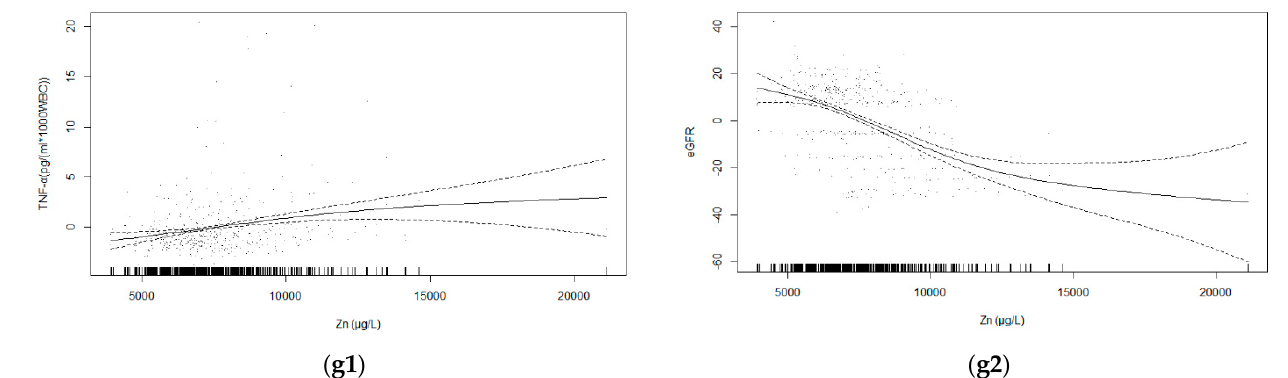
Figure 3. Relationships between ( a1 ) As ( p < 0.001), ( b1 ) Cd ( p = 0.062), ( c1 ) Pb ( p < 0.001), ( d1 ) Se ( p = 0.037), ( e1 ) Co ( p = 0.023), ( f1 ) Cu ( p = 0.165), ( g1 ) Zn ( p < 0.001) concentrations and the ratio of TNF- α and WBC based on generalized additive model after adjusting for age, gender, BMI, smoking status and alcohol consumption status. In addition are the relationships between ( a2 ) As ( p < 0.001), ( b2 ) Cd ( p = 0.003), ( c2 ) Pb ( p < 0.001), ( d2 ) Se ( p = 0.255), ( e2 ) Co ( p < 0.001), ( f2 ) Cu ( p < 0.001), ( g2 ) Zn ( p < 0.001) concentrations and eGFR based on adjusted generalized additive model.